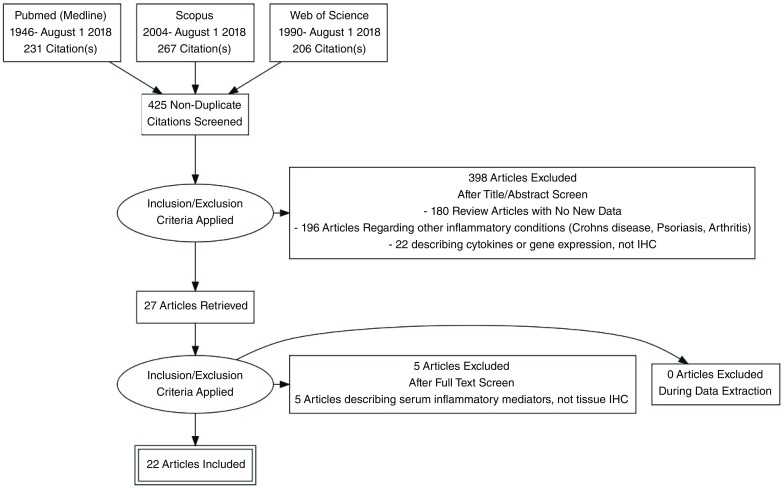
PRISMA flowchart.